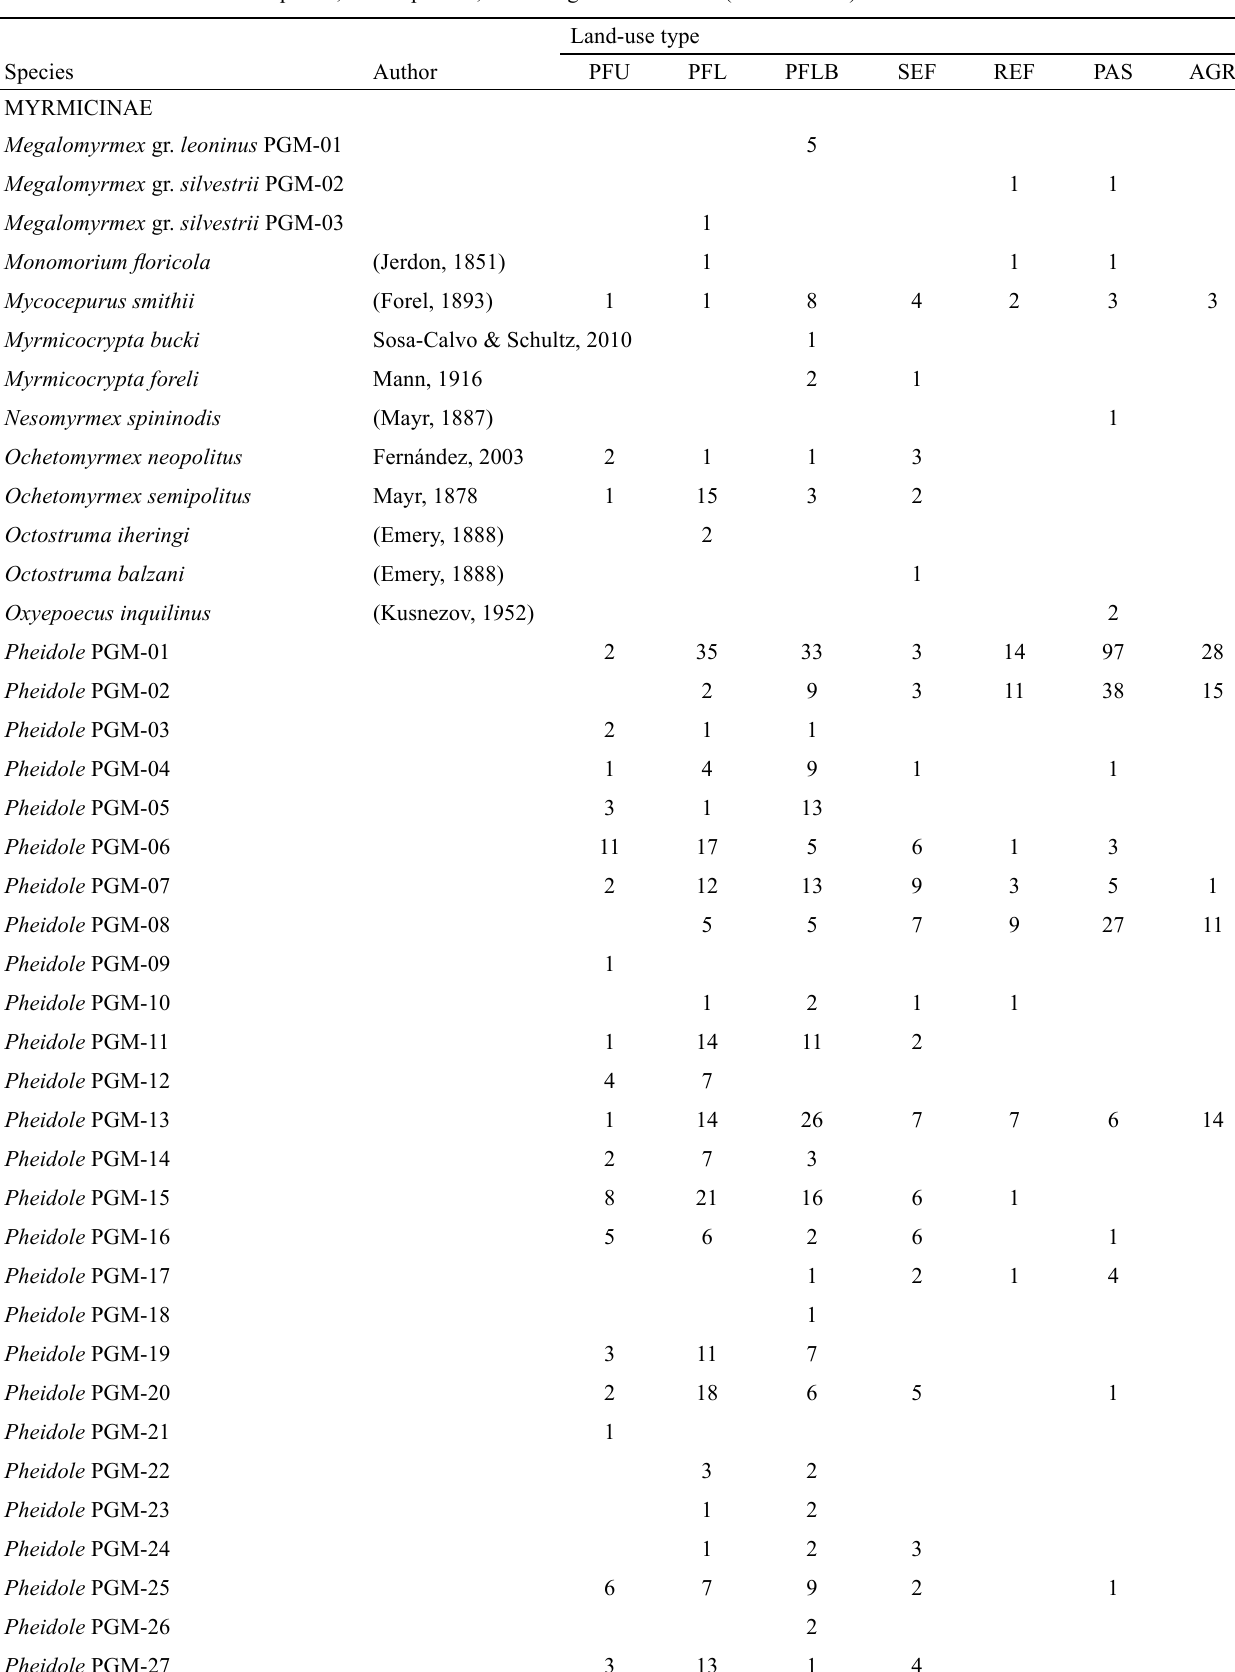
Table 2 . List of ant species collected in this study. Values represent number of records per pitfall traps of each species in each land-use type: PFU – primary forest undisturbed, PFL – primary forest logged, PFLB – primary forest logged and burnt, SEF – secondary forest, REF – reforestation with commercial species, PAS – pasture, AGR – agricultural areas.